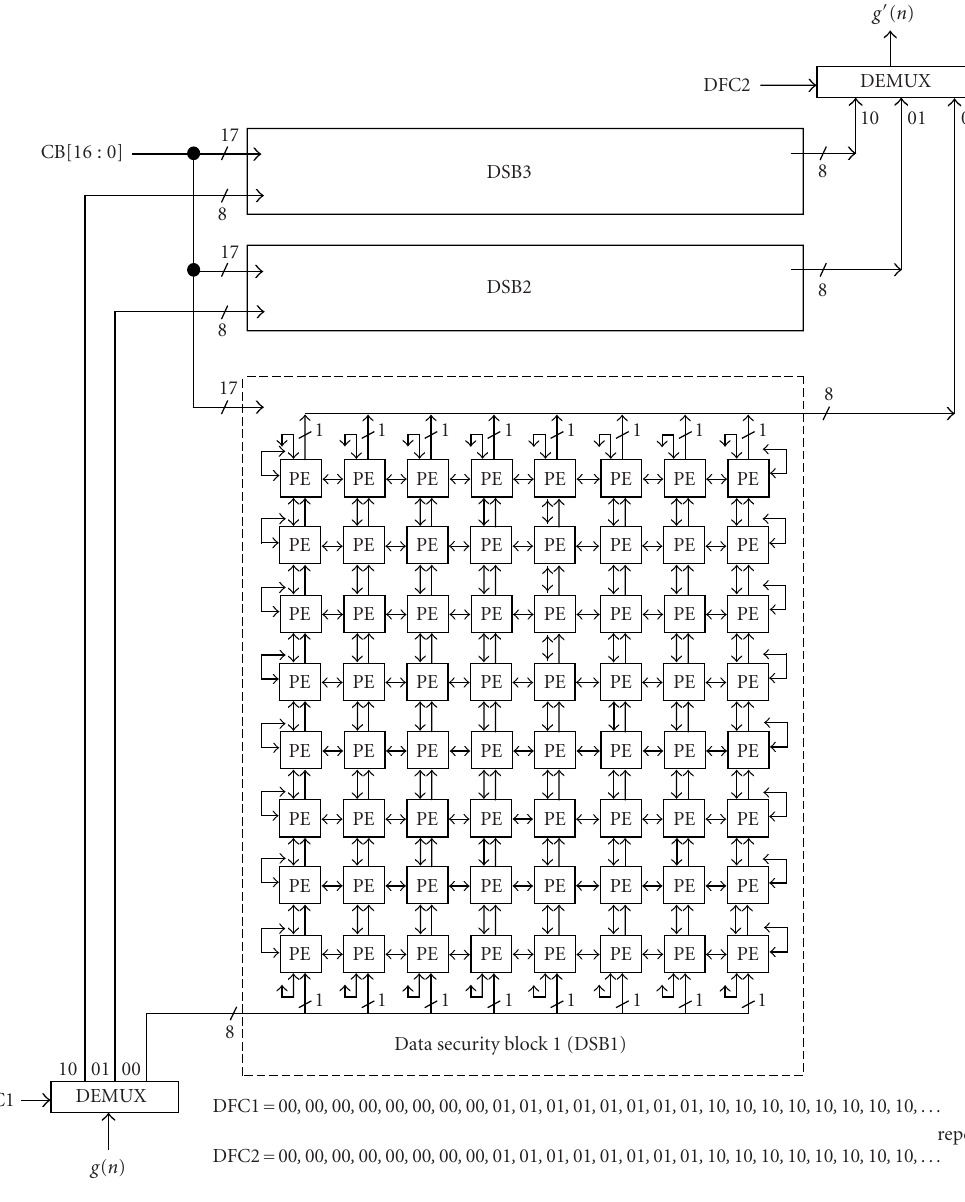
Figure 5: The architecture of the SEU/SDU in the proposed signal security system